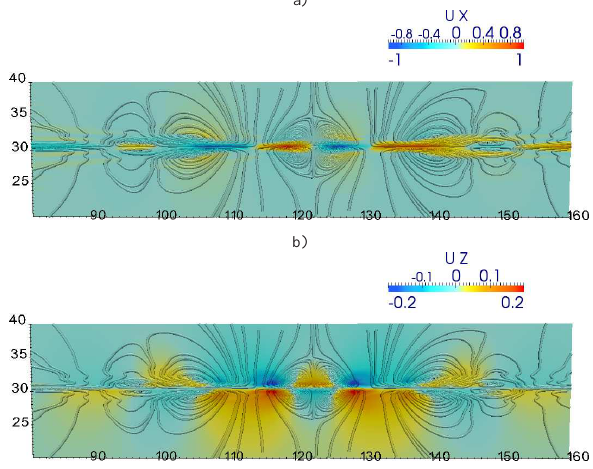
Fig. 8. Trajectory of Lagrangian markers. Miltiple trajectories are shown in different colours. Each trajectory starts at a circle and ends at a cross. The initial positions for the aprticles are equallys paced between x − L x = ± 7 L and x − L x / 2 = ± 14 L on either side from the center of the x-axis and at vertical position z/L = 29 . 9167, just a little below the central neutral